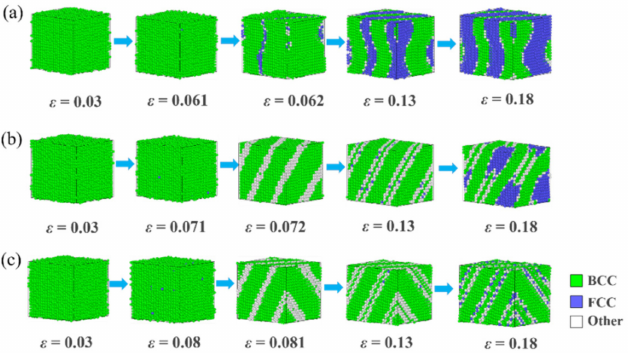
Figure 8. Atomic configurations of single-crystal tungsten at different strains during uniaxial tension in the presence of different pressures: ( a ) 0 GPa, ( b ) 8 GPa, and ( c ) 16 GPa.